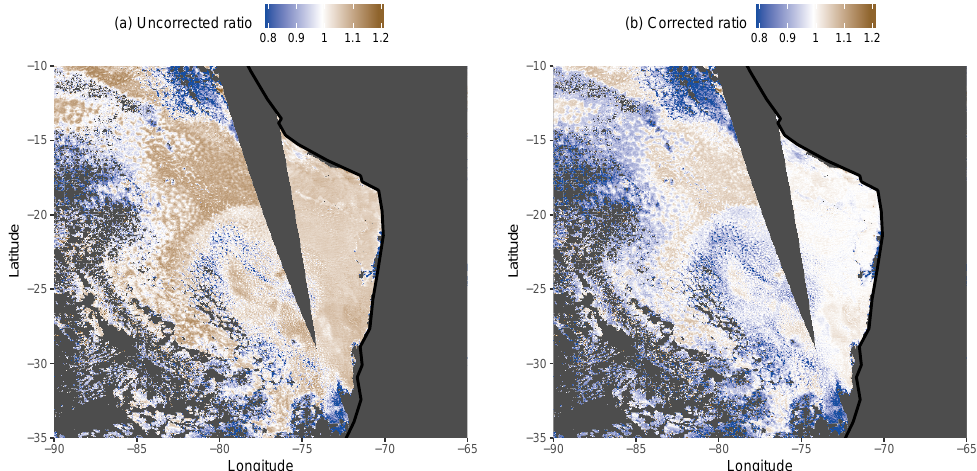
Figure 8. Ratios of r e3.7 to r e2.1 for a MODIS snapshot scene from the Southeast Pacific stratocumulus region from 16 June 2015. (a) Using uncorrected r e values. (b) Using r e values that have been corrected using the parameterizations for g re (for both r e3.7 and r e2.1 ). A ratio of 1 is expected for the plot on the right if the relative differences between r e3.7 and r e2.1 are caused by vertical stratification alone and if the parameterization is correctly predicting the relative differences.